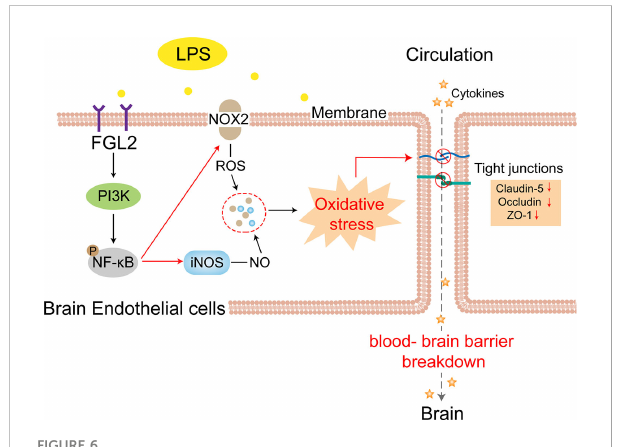
FIGURE 6 FGL2 de fi ciency attenuated blood-brain barrier disruption in maternal in fl ammation-exposed offspring. FGL2 de fi ciency downregulates the maternal in fl ammation-induced expressions of NOX2 and iNOS in BMECs via inhibiting PI3K/NF- k B pathway, which decreases the accumulation of ROS and NO. The reduced oxidative stress subsequently alleviates the declines of tight junction proteins (Claudin-5, Occludin, and ZO-1), thereby restoring permeability of blood-brain barrier and alleviating neuroin fl ammation in maternal in fl ammation-exposed